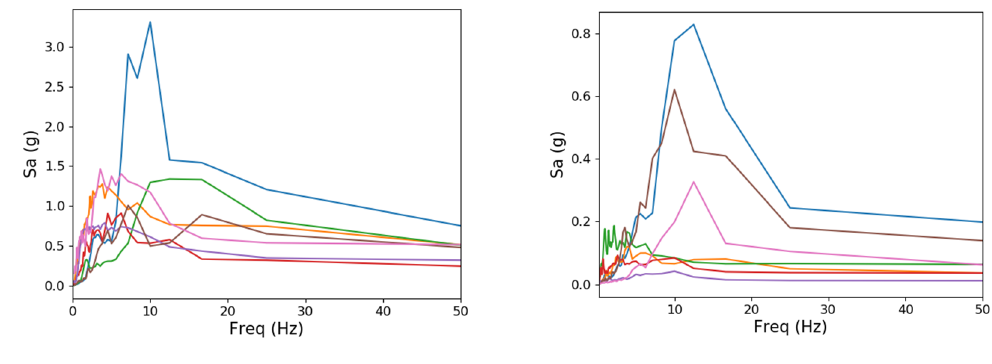
Figure 2. Spectral accelerations obtained from site response analyses for seven ground motions defined at the near and far faults: ( a ) Spectral accelerations for near-fault ground motions; ( b ) spectral accelerations for far-fault ground motions